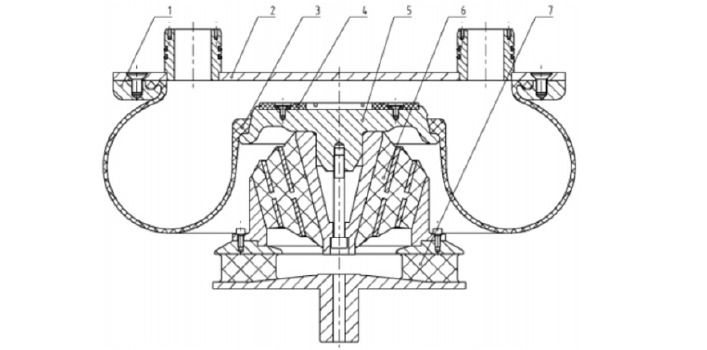
Figure 1. Air spring